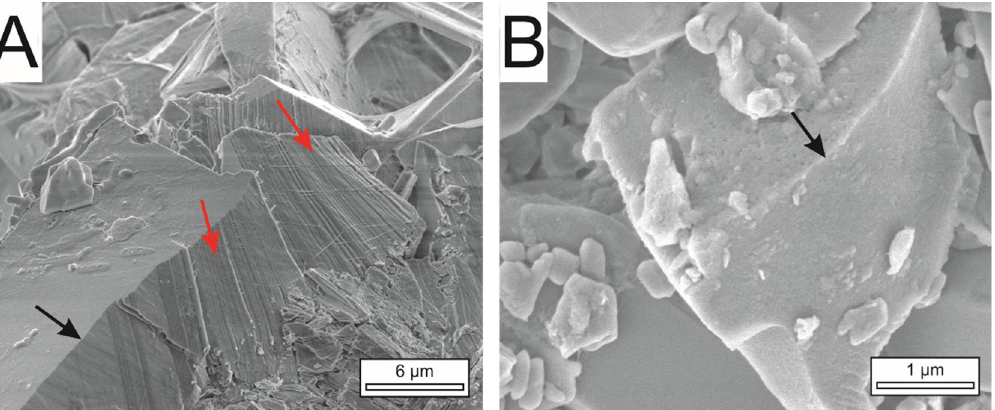
Figure 8. FE-SEM images of ( A ) coarse-grained and ( B ) fine-grained substrates. Note the exfoliation planes in the parallel lines of gypsum grains in ( A ) (red arrows) and imperfect fractures in ( A , B ) (black arrows).